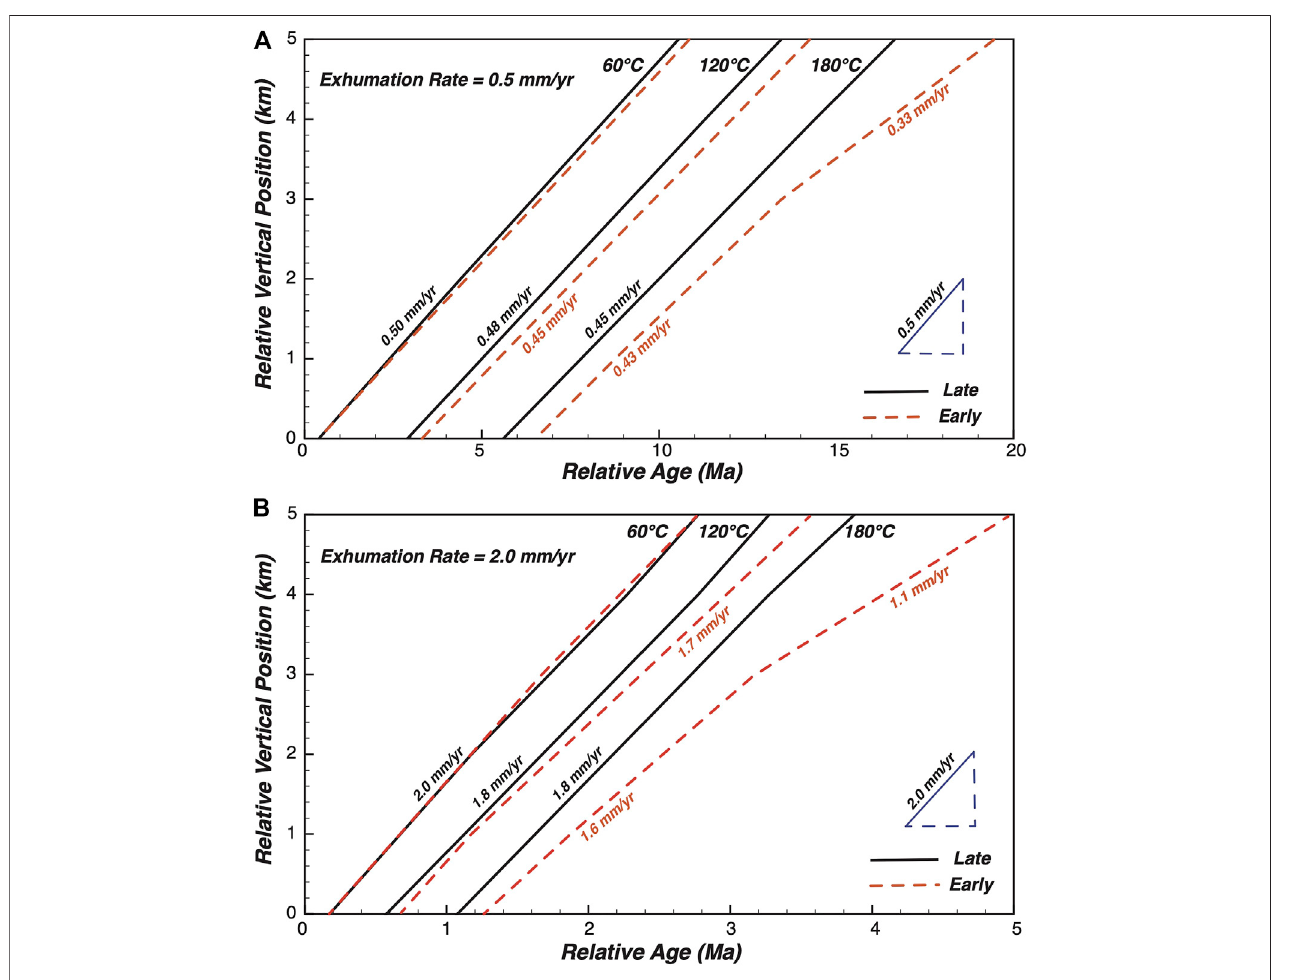
FIGURE 6 | Apparent Exhumation Rate determined from vertical age-elevation pro fi les for a range of thermochronologic closure temperatures and relative time of age acquisition during the exhumation event. The 5-km depth intervals for samples used to generate this fi gure (early vs. late) is indicated on the T – z plot ( Figure 3C ).